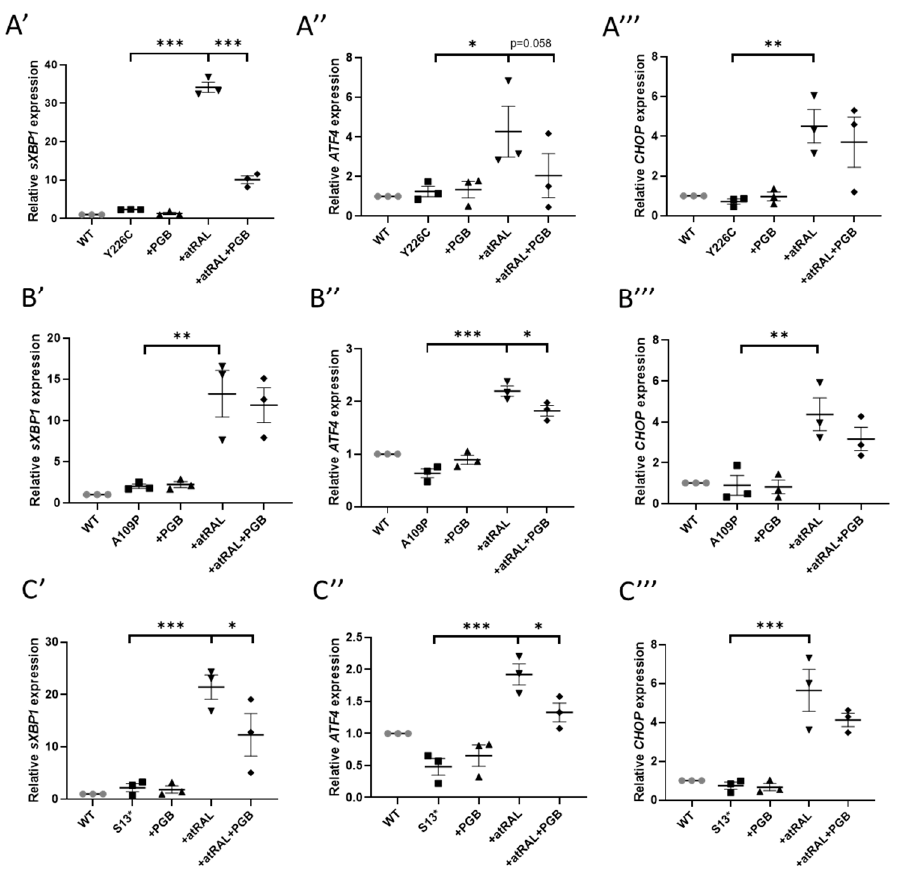
Figure 3. atRAL-induced ER stress was attenuated by pregabalin. Cells were dosed with 50 µM atRAL, 1 mM pregabalin (PGB), or both for 24 h. RT-qPCR was performed analysing the expression of ER stress markers. Dosing with atRAL significantly increased expression of s XBP1 , ATF4 , and CHOP in p.Y226C ( A ), p.A109P ( B ), and p.S13* ( C ) cell lines. Dosing with pregabalin reduced expression of ER stress markers. Statistical significance was analysed using one-way ANOVA and Sidak’s multiple comparison test. * p ≤ 0.05, ** p ≤ 0.01, *** p ≤ 0.001.